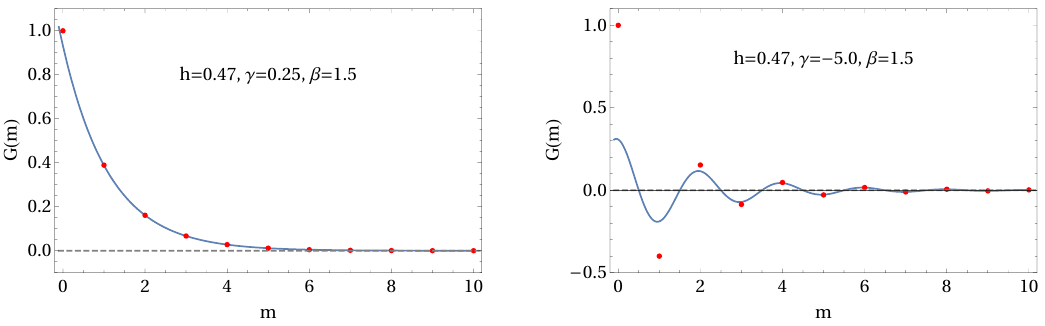
Figure 2: The exact values of the correlation function G ( m ) (red dots) and its large distance asymptotics (blue solid curves). The left panel corresponds to h = 0.47, γ = 0.25, β = 1.5, and δ = + 1. The right panel corresponds to h = 0.47, γ = − 5.0, β = 1.5, and δ = −